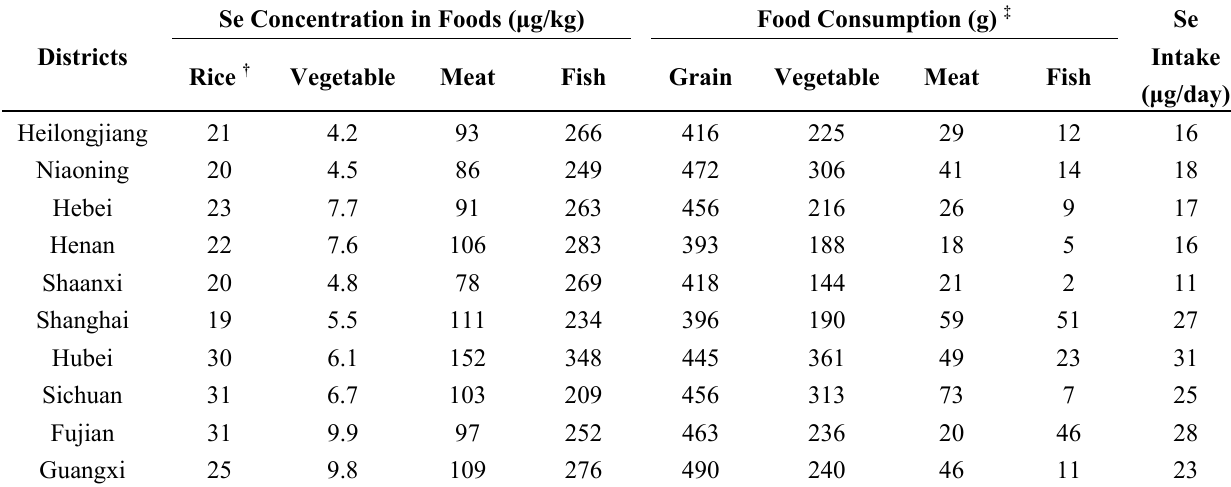
Table 3. Selenium content in different foods and calculated daily Se intake for different Chinese districts.